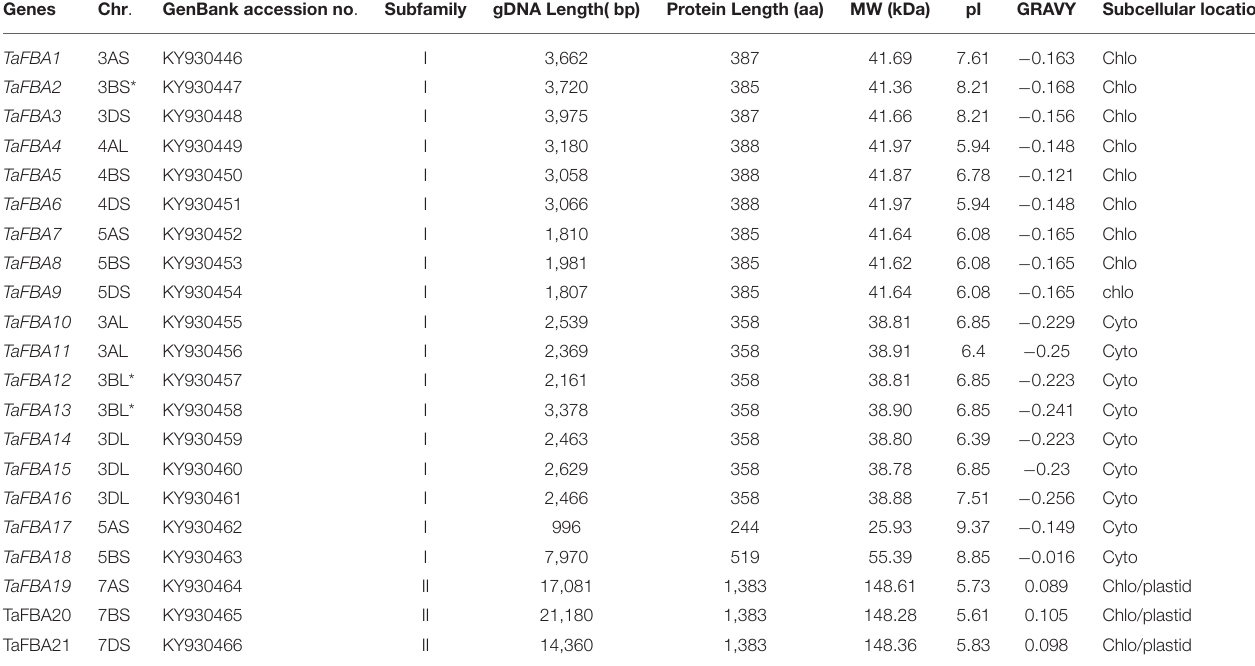
TABLE 1 | The molecular characteristics of TaFBA genes and the prediction of chromosomal and subcellular location. Genes Chr